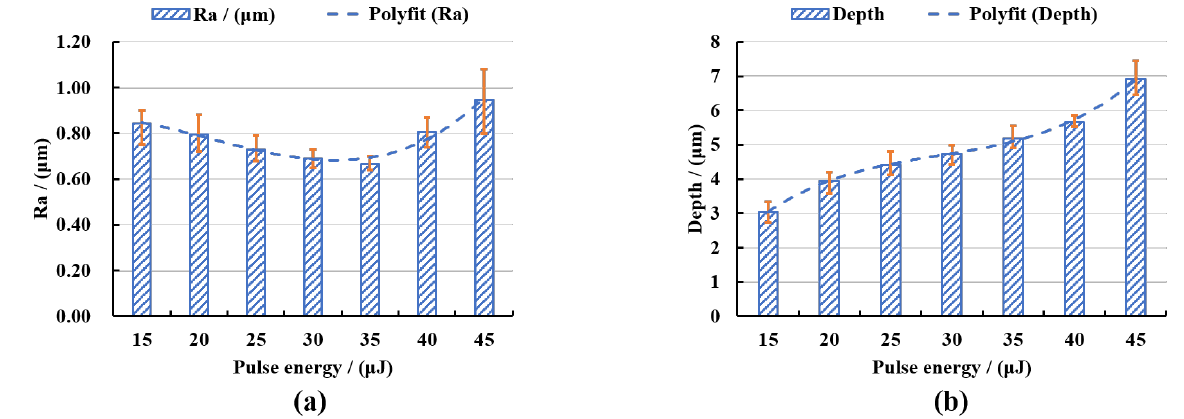
Figure 8. ( a ) The variation of surface roughness with pulse energy and ( b ) the variation of polishing depth with pulse energy.